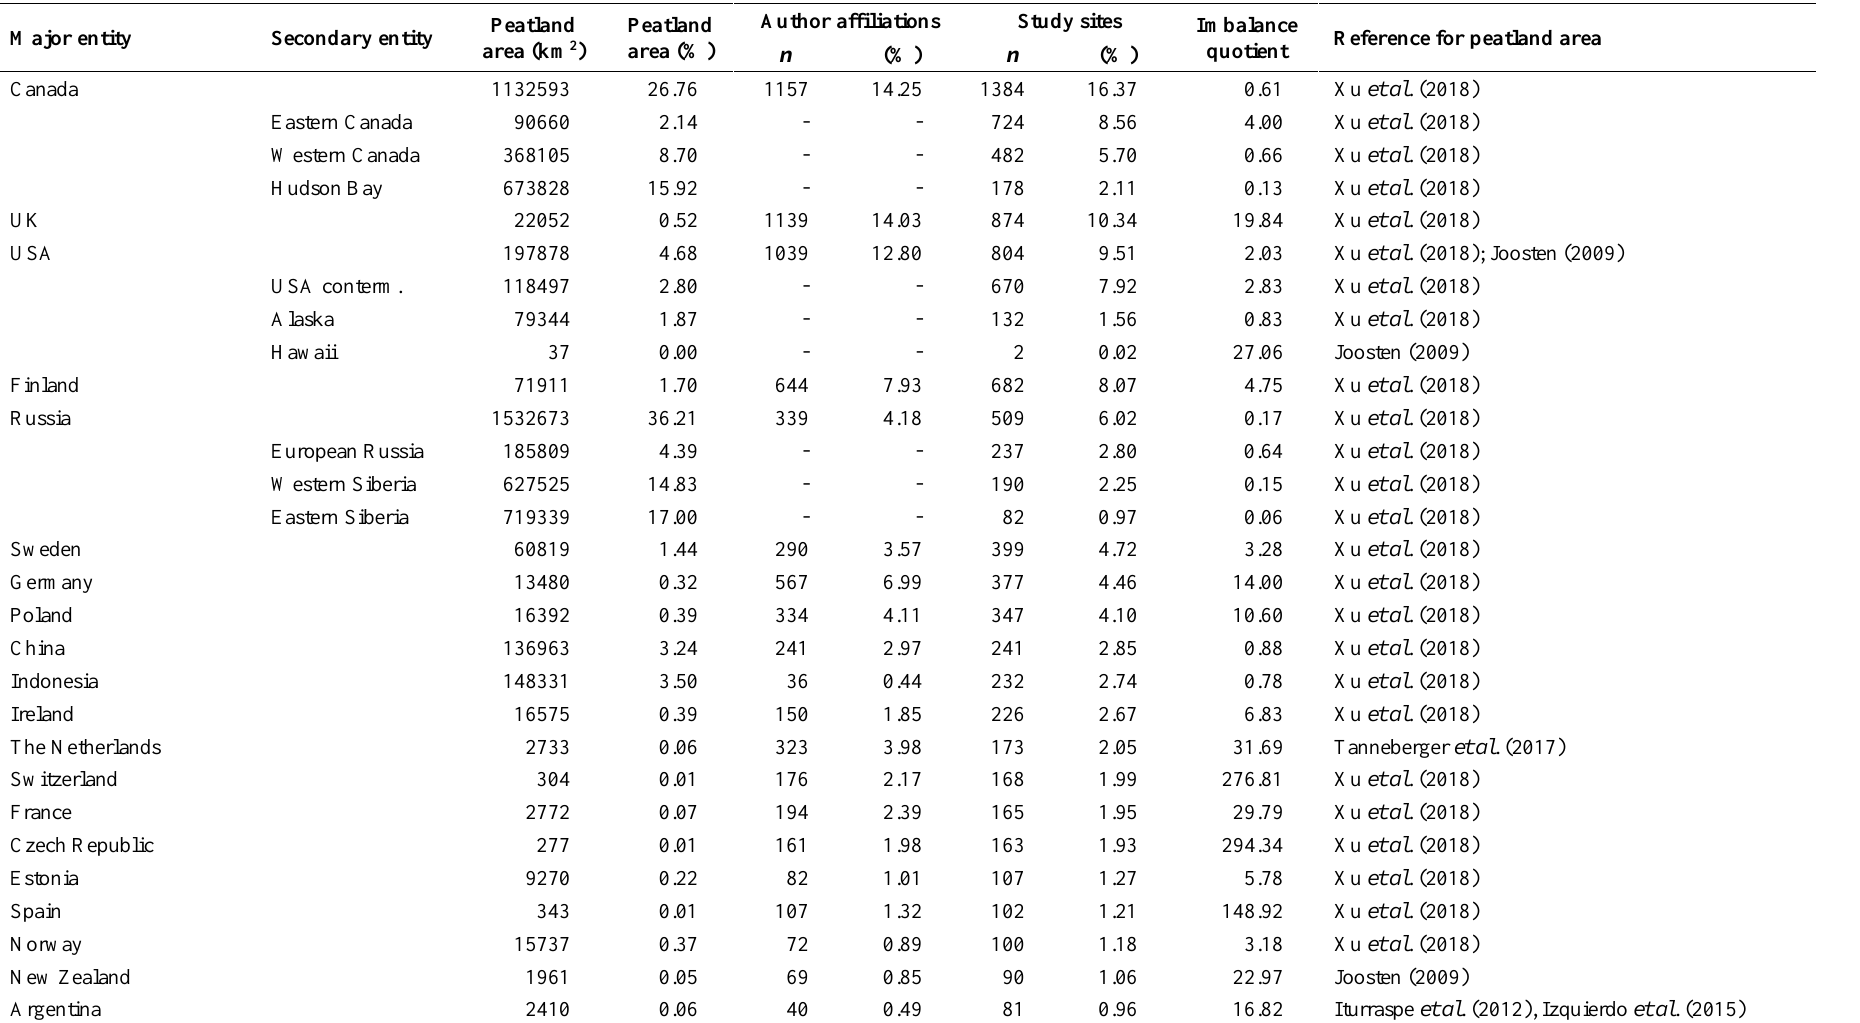
Table A3. Absolute and relative peatland area, numbers of author affiliations and study sites, at the level of countries and regions. Countries and regions are ranked by the number of study